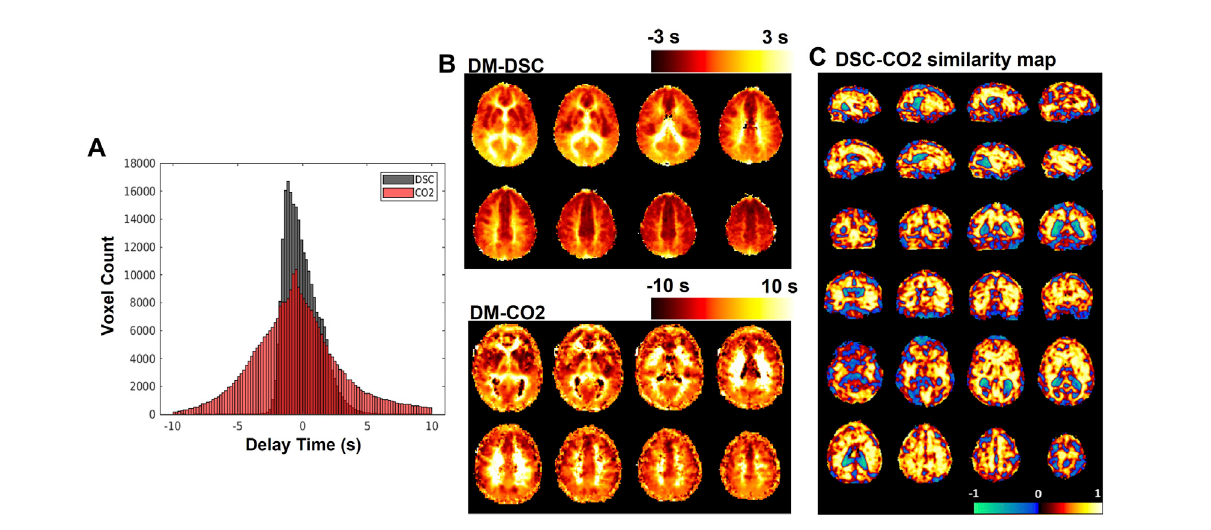
FIGURE 4 (A) Histograms of delay maps computed from DSC-MRI and CO 2 -challenge fMRI. (B) Sample slices of subject-averaged DSC-MRI and CO 2 -fMRI delay maps. (C) SSIM map displaying local (per-voxel) structural similarity s values comparing subject-averaged DSC bolus arrival delay map with the subject-averaged original CO 2 arrival delay map. The structural similarity metric s can be interpreted similarly to Pearson ’ s correlation coef fi cient; values range from − 1 to 1, where high positive values indicate higher structural similarity, lower negative values indicate inverted structural similarity, and values near zero represent little